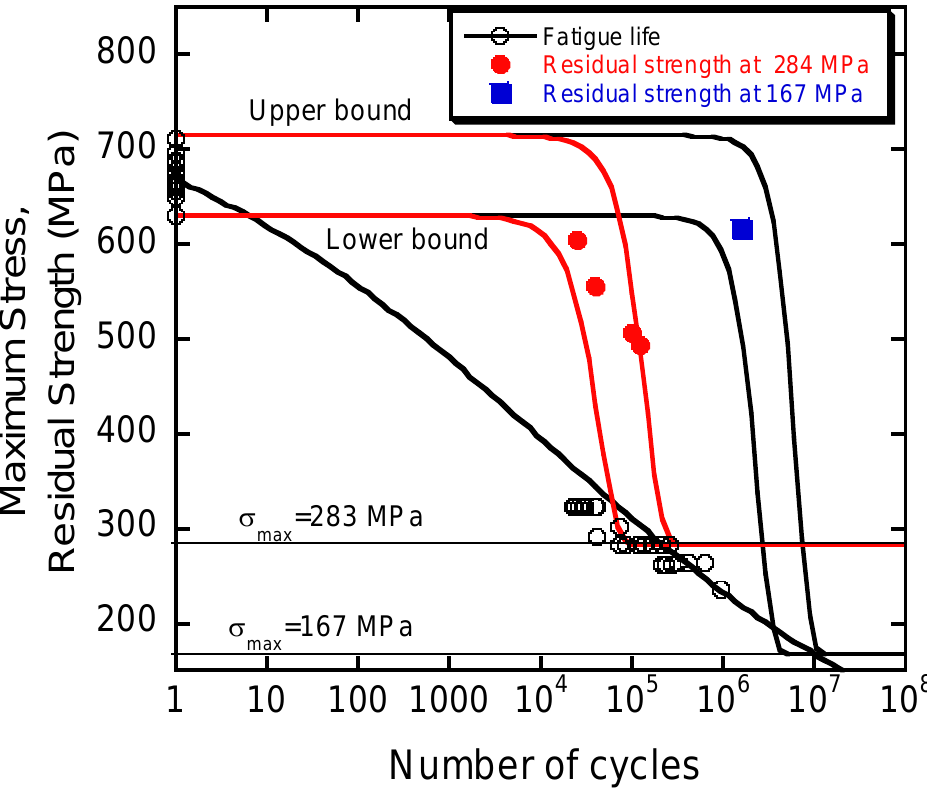
Figure 5. Theoretical upper and lower bounds of residual strength evolution for a glass-fiber-reinforced polyester used as a blade material for wind turbines. The stacking sequence comprised a chopped strand mat (CSM), with unidirectionally (UD) reinforced and fabric layers in the following sequence [CSM, fabric, and (CSM and UD) 2 ] s . The average volume fraction of fibers was 41%. The experimental data in terms of fatigue life and residual strength data taken at different maximum stresses, namely 167 and 283 MPa, and at a different number of cycles are re-elaborated from Ref. [11].